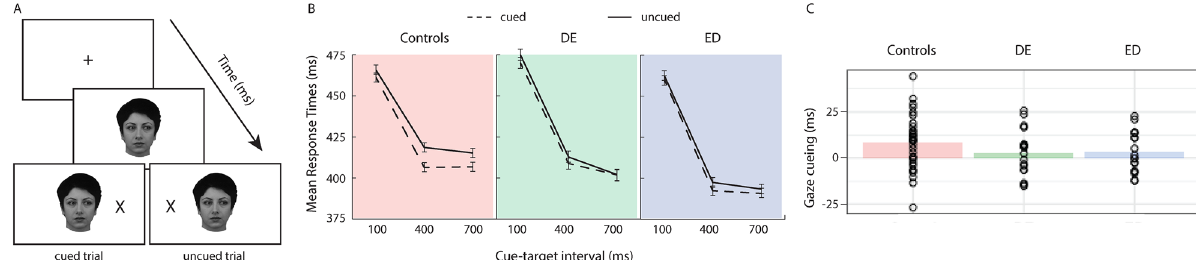
Figure 1. ( A ) depicts the gaze cueing task sequence, with the bottom-left image depicting a cued trial and the bottom-right depicting an uncued trial. ( B ) shows mean interparticipant correct response times as a function of Cue validity and Cue‑target interval by group (Controls, DE, and ED; error bars are standard error of the difference between the means). ( C ) depicts both the average magnitude of gaze cueing (calculated as the average uncued RT—the average cued RT) for each group (coloured bars) and the individual data points illustrating each participant’s magnitude of gaze